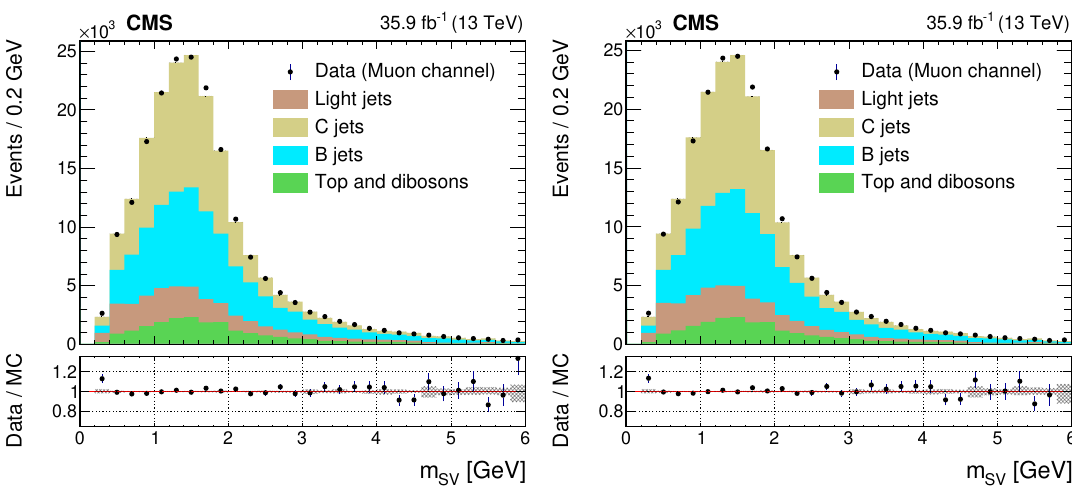
of the highest- p c -tagged central jet, for SV T (left) and c -tagged central jet T